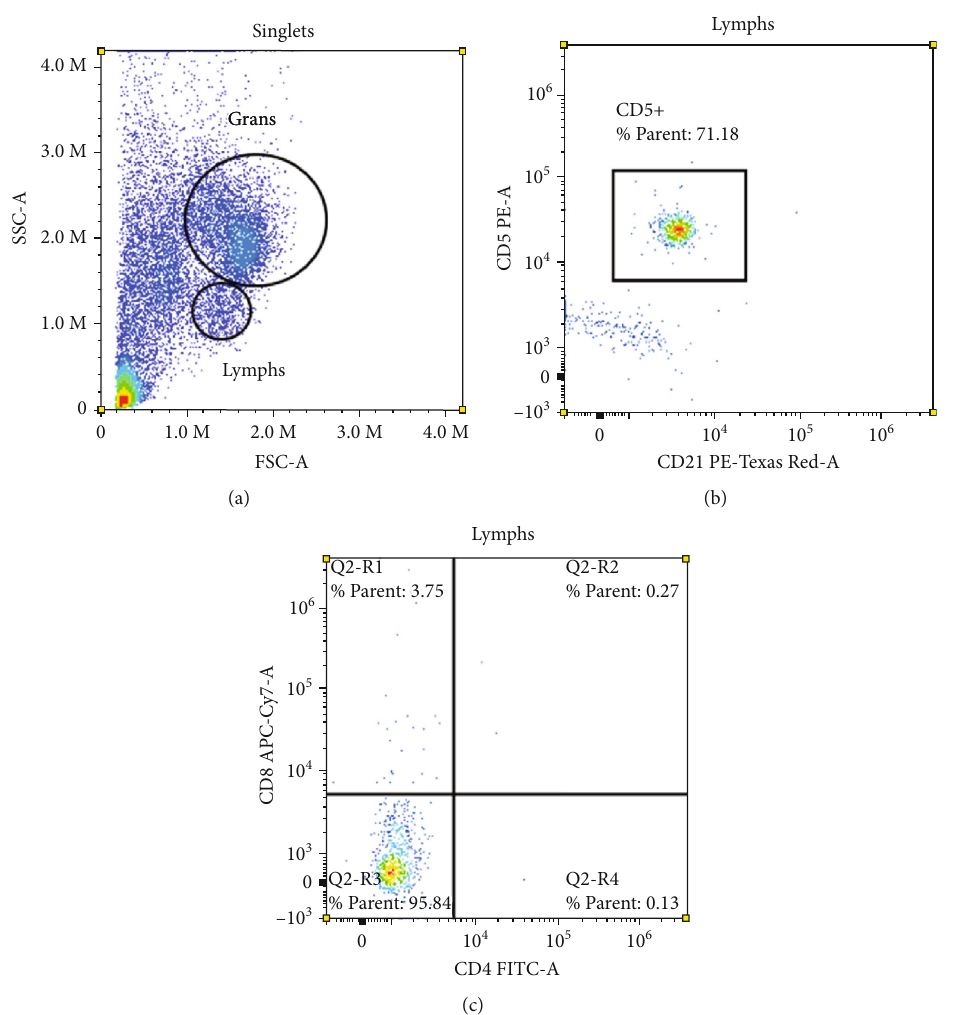
Figure 1: Flow cytograms of a liver aspirate sample. (a) Two scatter gates are drawn around granulocytes (larger, more complex cells) and lymphocytes (smaller, less complex cells). (b) Approximately 71% of the cells in the lymphocyte gate are positive for CD5 (T-cell marker) and negative for CD21 (B-cell marker). (c) The vast majority of these cells ( ~ 96%) are negative for the T-cell subset antigens CD4 and